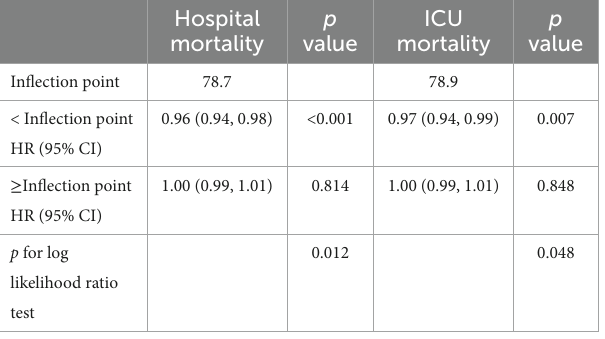
TABLE 3 Threshold effect of GNRI on all-cause hospital and ICU